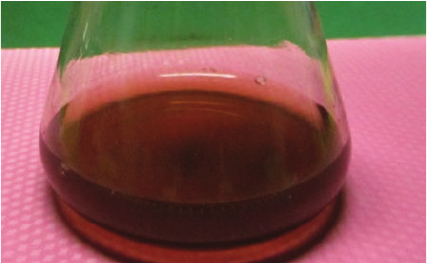
Figure 2: Color change to reddish brown after treating filtrate of endophytic fungi, Penicillium sp., with 1 mM AgNO 3